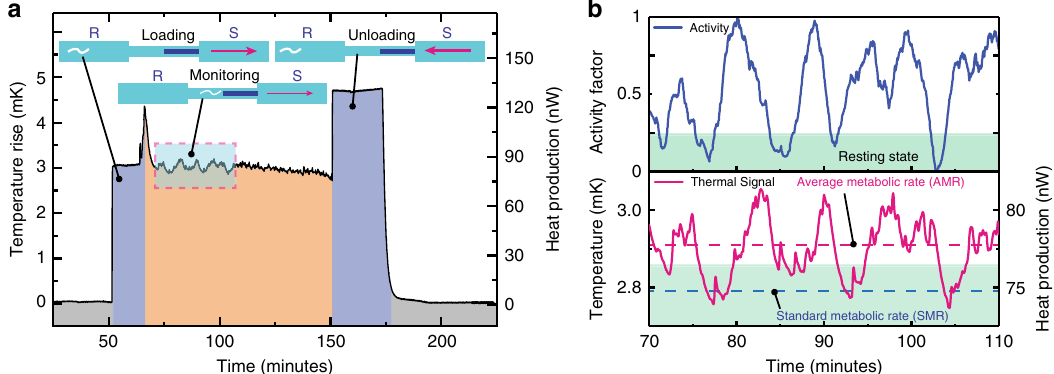
Fig. 3 C. elegans metabolic heat output measurement and analysis. a A typical procedure to measure heat output from a single C. elegans involves establishing an initial reference (gray region), followed by loading the worm (violet region) from the reservoir side (R) with a syringe pump (S) at withdraw fl ow rates (R → S) of ~2 – 10 µ l min − 1 . The orange region indicates the monitoring phase (1 – 2 h), followed by unloading (R ← S, violet region) at fl ow rates of ~2 – 10 µ l min − 1 . b Temperature rise (magenta plot in bottom panel) and activity factor (blue plot in top panel) of a reference measurement (marked blue region in Fig. 3a). In the panel showing the activity factor, the worm ’ s resting activity level is highlighted in green. From the corresponding metabolic signal, SMR (blue dashed line, bottom panel) is derived. AMR (magenta dashed line, bottom panel) is determined by averaging the thermal signal in a 30-minute time